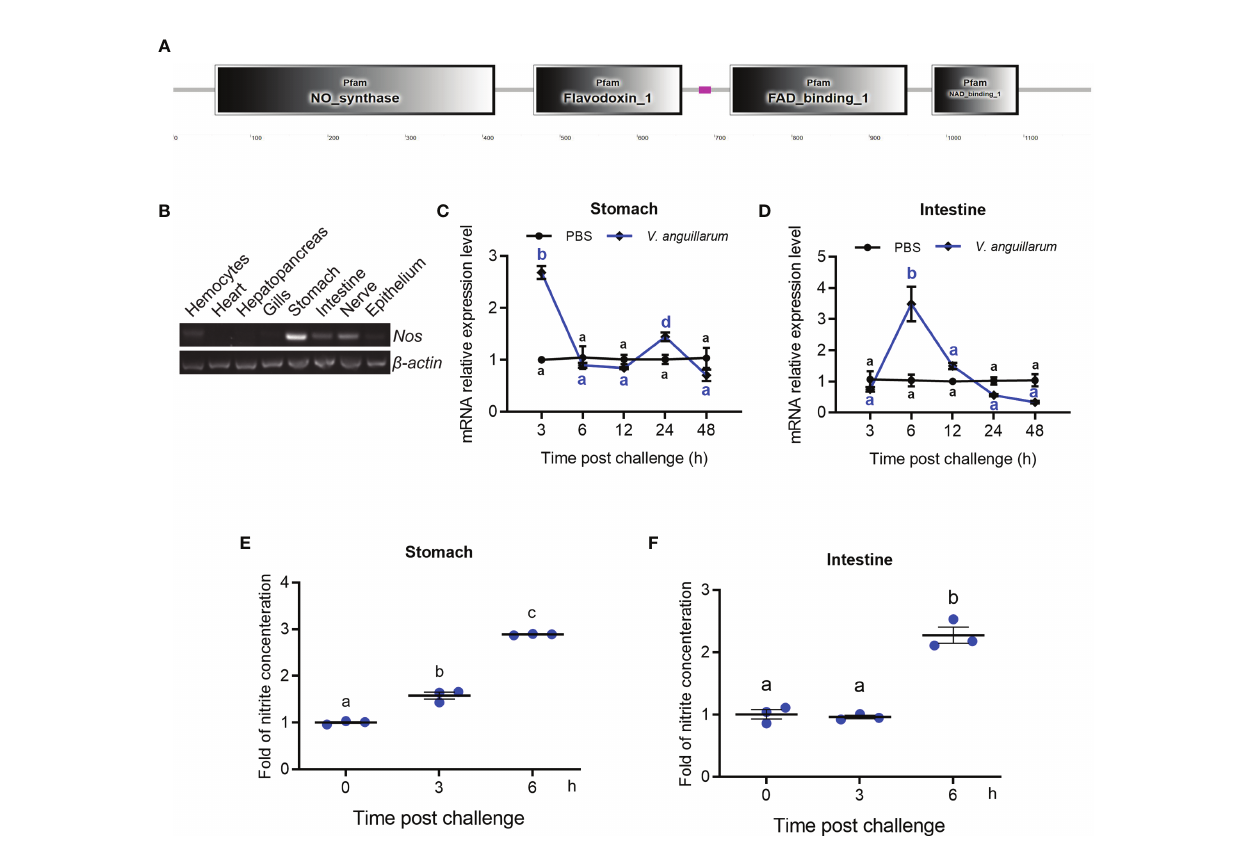
FIGURE 1 | Tissue distribution and expression patterns of Nos in shrimp challenged by bacteria. (A) Domain architecture of shrimp NOS analyzed in the SMART web site (http://smart.embl-heidelberg.de). (B) Tissue distribution of Nos in hemocytes and different organs. (C, D) The expression patterns of Nos in the stomach (C) and intestines (D) in shrimp after V. anguillarum challenge, as analyzed using qRT-PCR; PBS injection was used as the control. (E, F) The concentration of nitrite in the stomach (E) and intestines (F) of shrimp after V. anguillarum challenge, as analyzed using the nitrite concentration determination method. Data represent the mean ± SD ( n = 3). One-way ANOVA was used for multiple comparisons, the different lowercase letters indicate signi fi cant differences ( p < 0.05) in the ANOVA